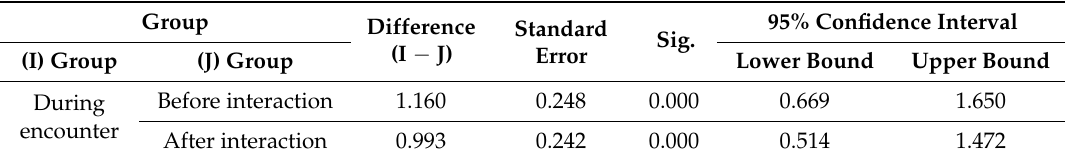
Table 7. The differences in maximum wind speed changes within a 6-h span before, during, and after interactions between TCs and warm ocean eddies. Sum of Squares df Mean Square F Sig. Between groups 35.853 2 17.927 13.137 0.000 Within groups 180.123 132 1.365 Sum 215.976 134 Table 8. T -test results showing the differences in maximum wind speed changes within a 6-h span before, during, and after interactions between TCs and warm ocean eddies. 95% Confidence Interval Group Difference Standard Sig. (I − J) Error (J) Group Lower Bound Upper Bound Before interaction 1.160 0.248 0.000 0.669 1.650 During encounter After interaction 0.993 0.242 0.000 0.514